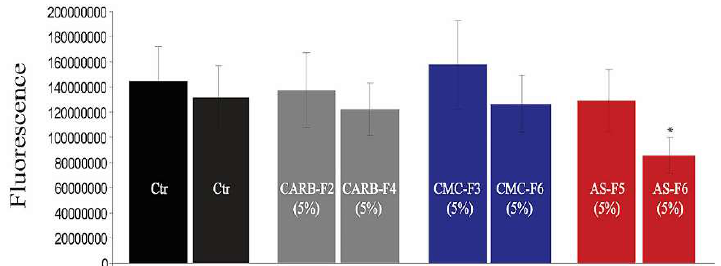
Figure 5. Viability of normal dermal cells (Primary Dermal Endothelial Cells (PDMC)) for gel formulations without and with CD-NHF ( N = 15 wells/column from two independent experiments). Ctr (Control).